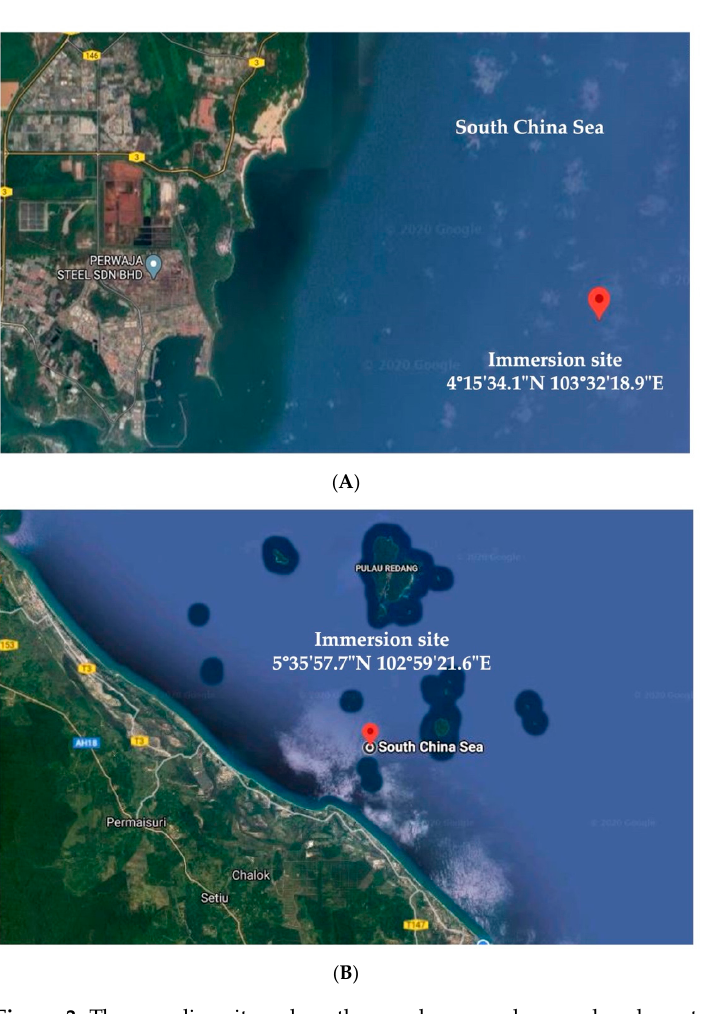
Figure 3. The sampling sites where the panels were submerged underwater; are ( A ) Kemaman, and ( B ) Pulau Redang. https://www.google.com/maps/@5.3873277,103.0933283,15z, accessed on 6 May 2021.